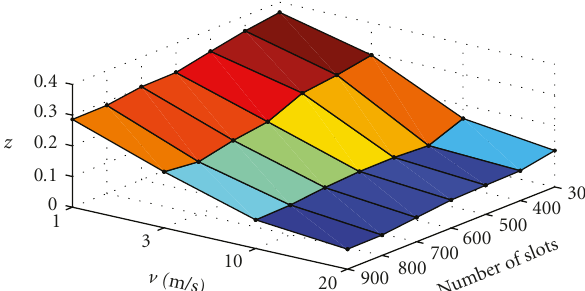
Figure 8: The threshold z values, which keep the false alarm rate Pr(LOS | ( T = NLOS)) at 0 . 05 confidence level, for di ff erent number of slots and v